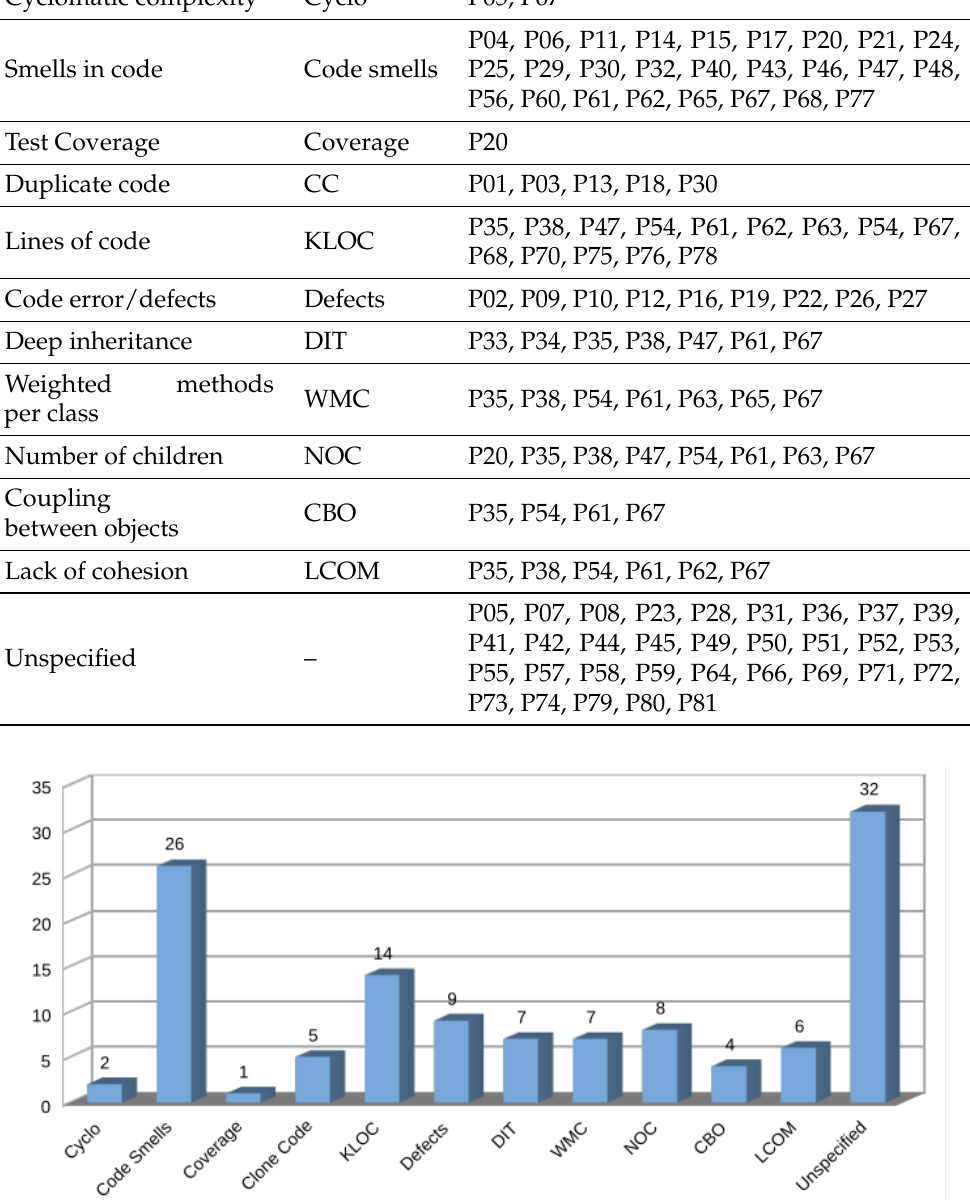
Figure 11. Types of metrics used in